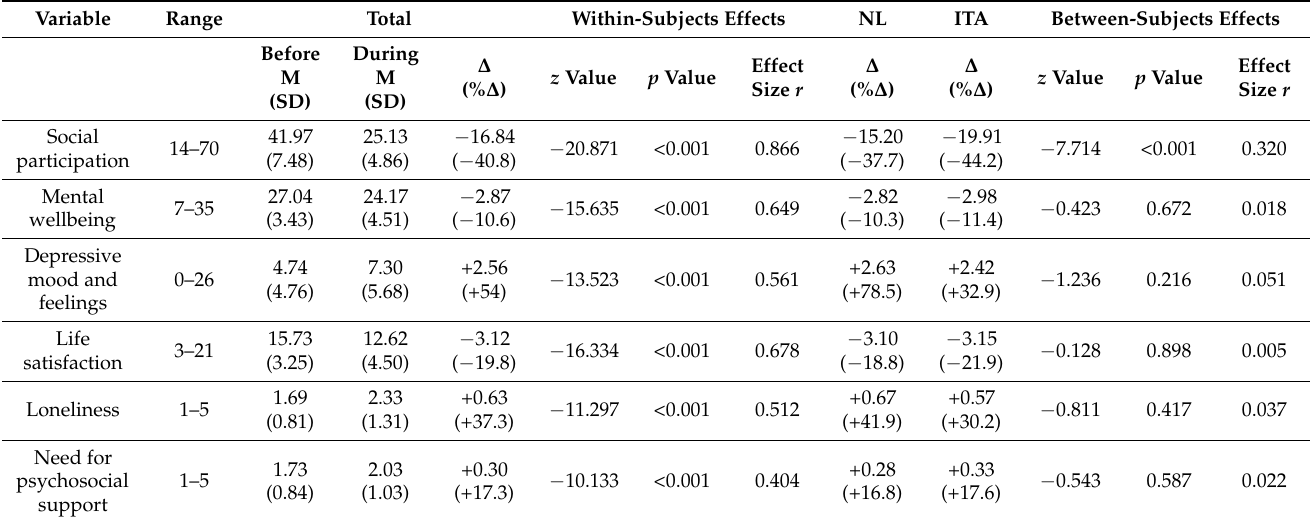
Table 2. Psychosocial effects of COVID-19 home confinement within and between Dutch and Italian residents. Variable